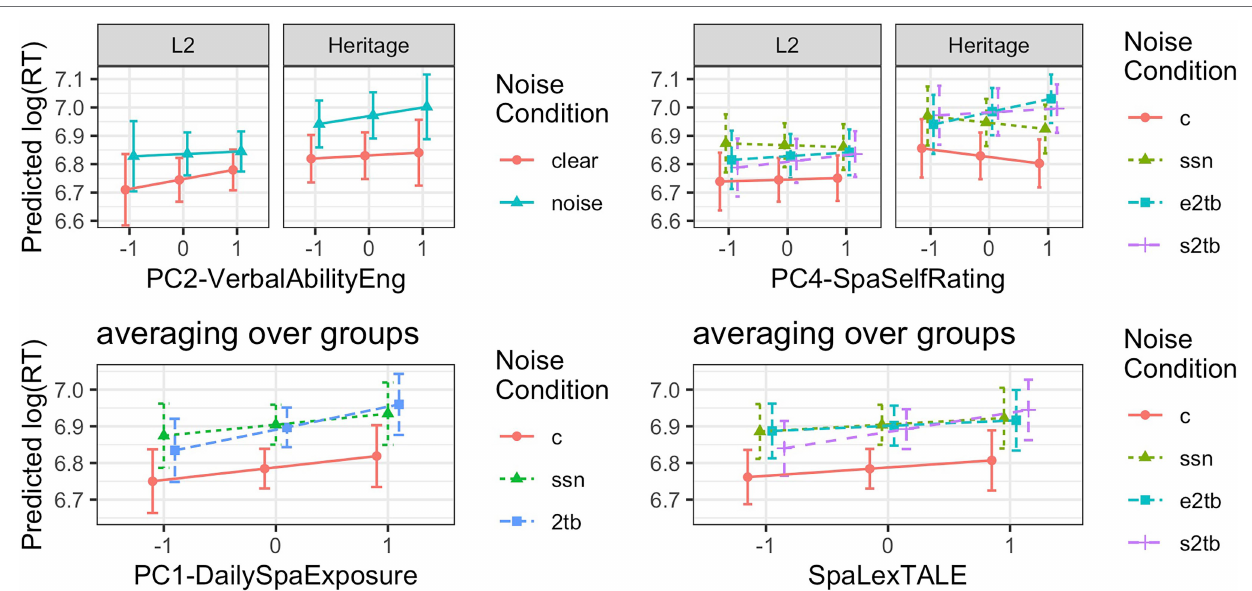
FIGURE 5 | Predicted response times (estimated marginal means with prediction intervals) depicting significant predictors for noise masking effects in the fitted model in Table 8 . All predictors have been centered and scaled, with estimated marginal means generated at the mean ± 1 SD . (c = clear, ssn = speech-shaped noise, e2tb = English two-talker babble, and s2tb = Spanish two-talker